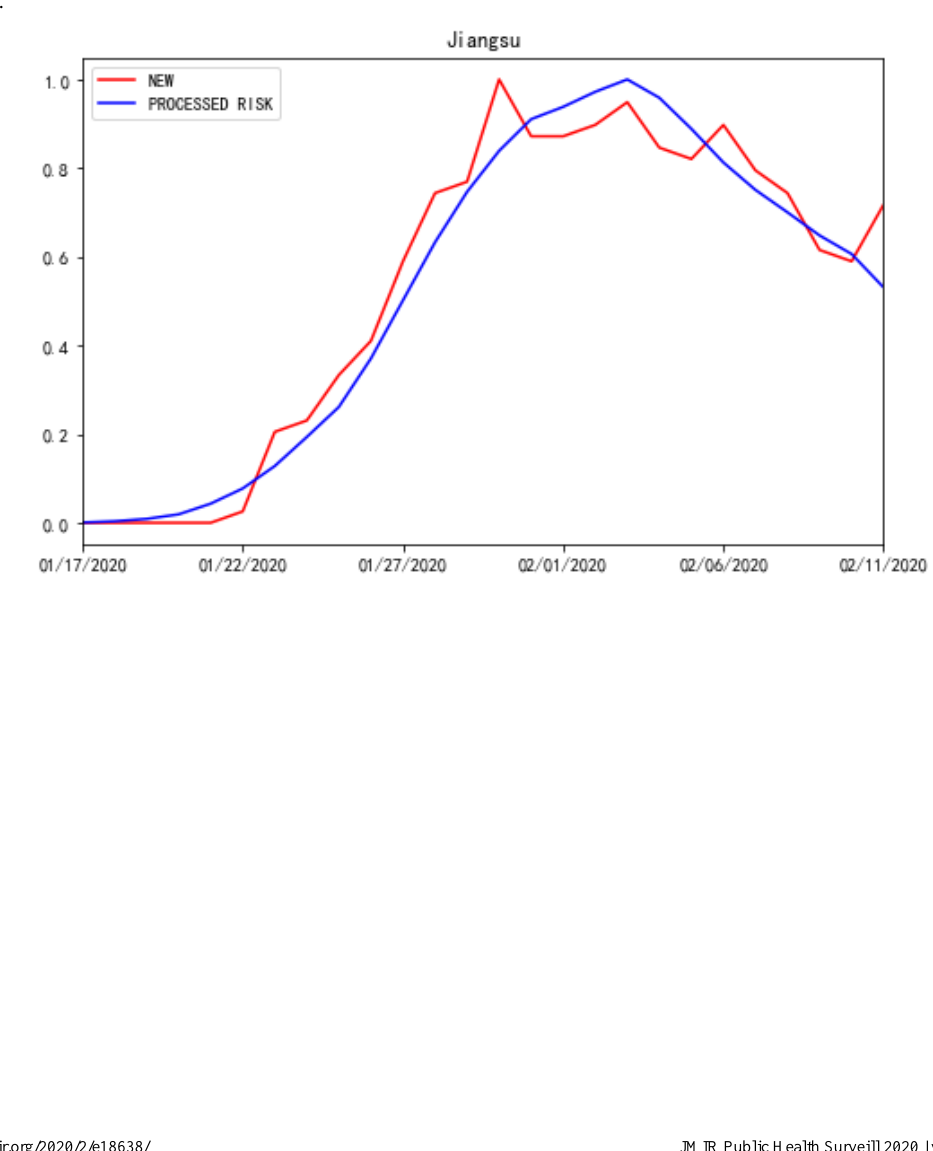
Figure 6. The polyline chart of NEW and PROCESSED RISK for Jiangsu Province from January 17, 2020 to February 11, 2020 when OFFSET=0 and